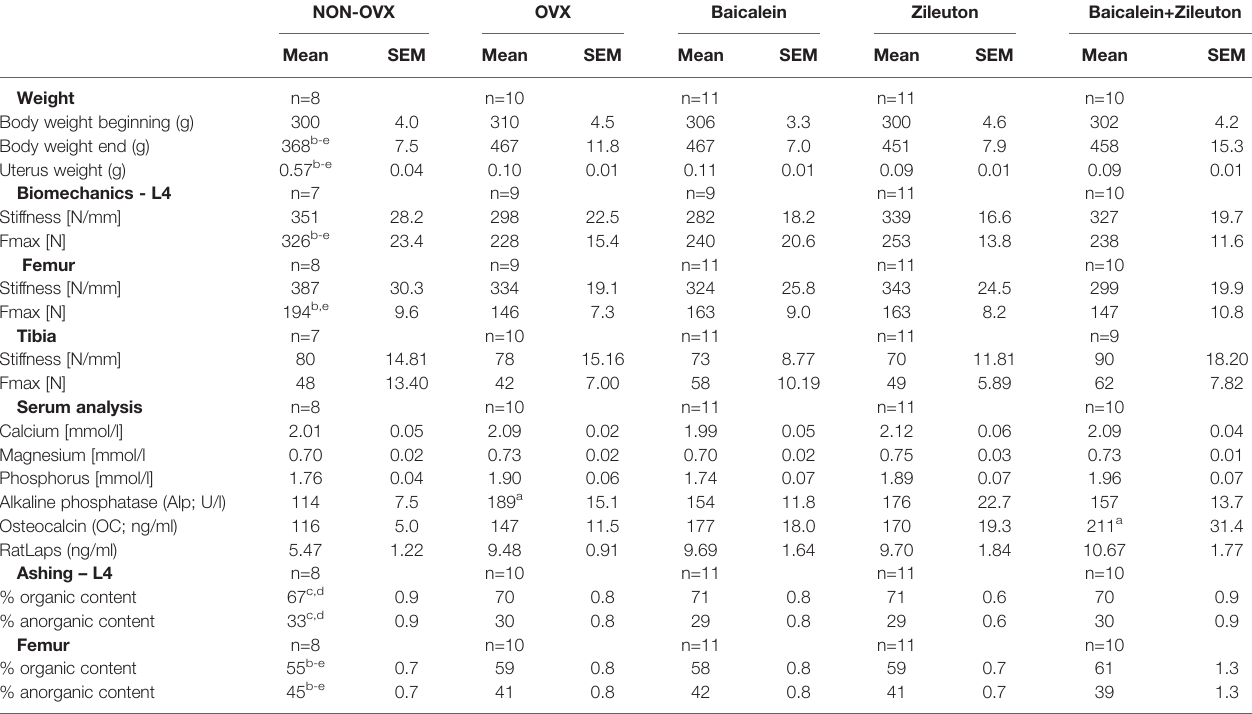
TABLE 1 | Body weight, uterus weight, serum analyses, biomechanical and ashing analyses of bone. NON-OVX